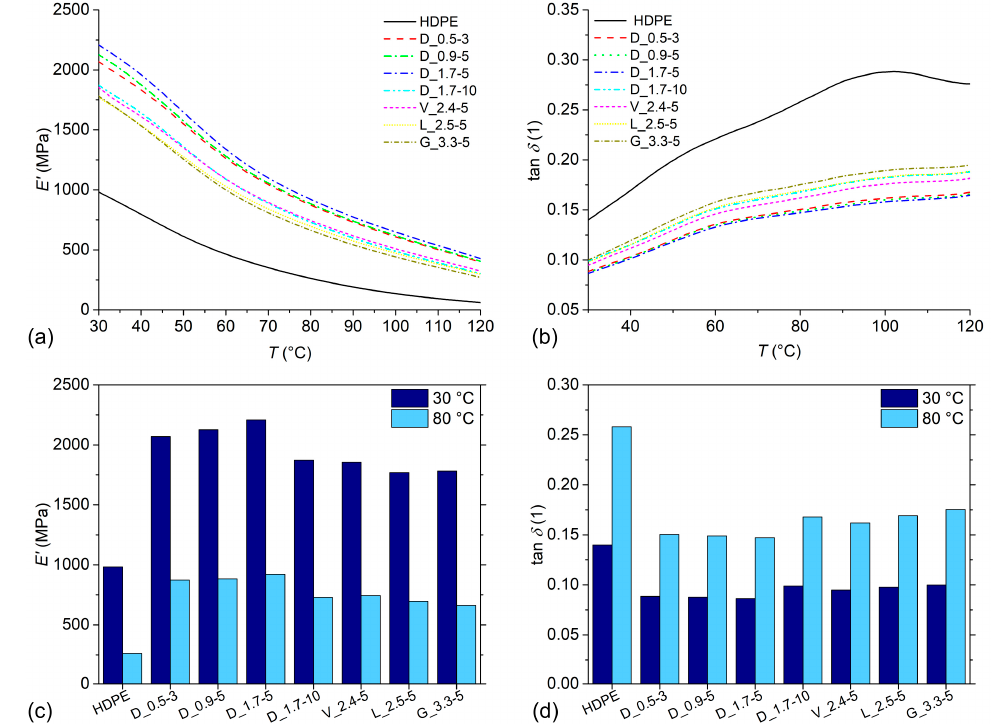
Figure 7. Dynamic mechanical properties of samples: ( a ) storage modulus E (cid:48) as a function of temperature; ( b ) loss factor tan δ as a function of temperature; ( c ) values of storage modulus E (cid:48) at 30 ◦ C and 80 ◦ C; ( d ) values of loss factor tan δ at 30 ◦ C and 80 ◦ C.